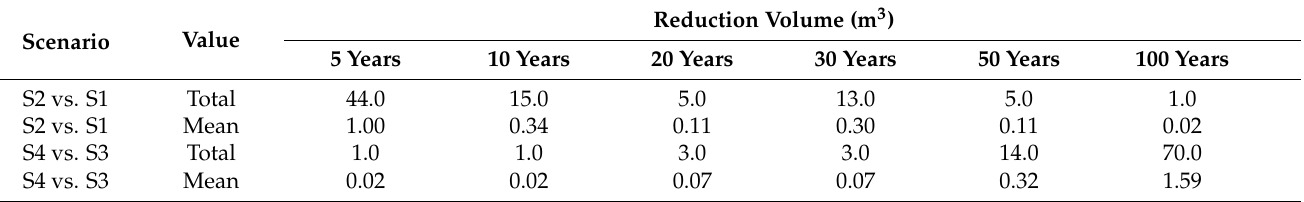
Table 9. Reduction in overflow volume of junction nodes for the discharge route scenarios (S2 and S4) compared to traditional roof scenario (S1) and green roof scenario